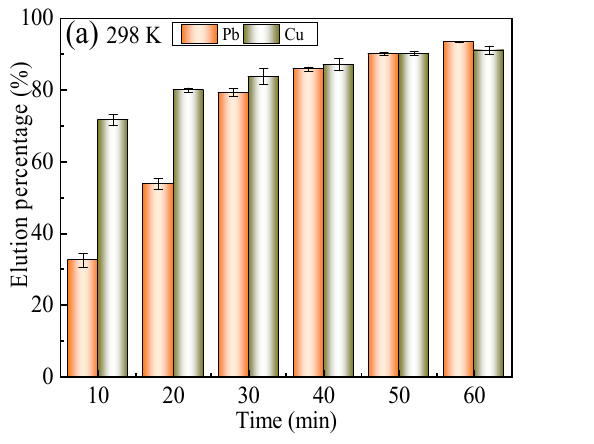
Figure 8. Variation of elution percentage of Pb(II) and Cu(II) with ( a ) time and ( b ) temperature (elution agent: 3% HCl, liquid–solid ratio: 50 mL/g, initial concentration: 100 mg/L).